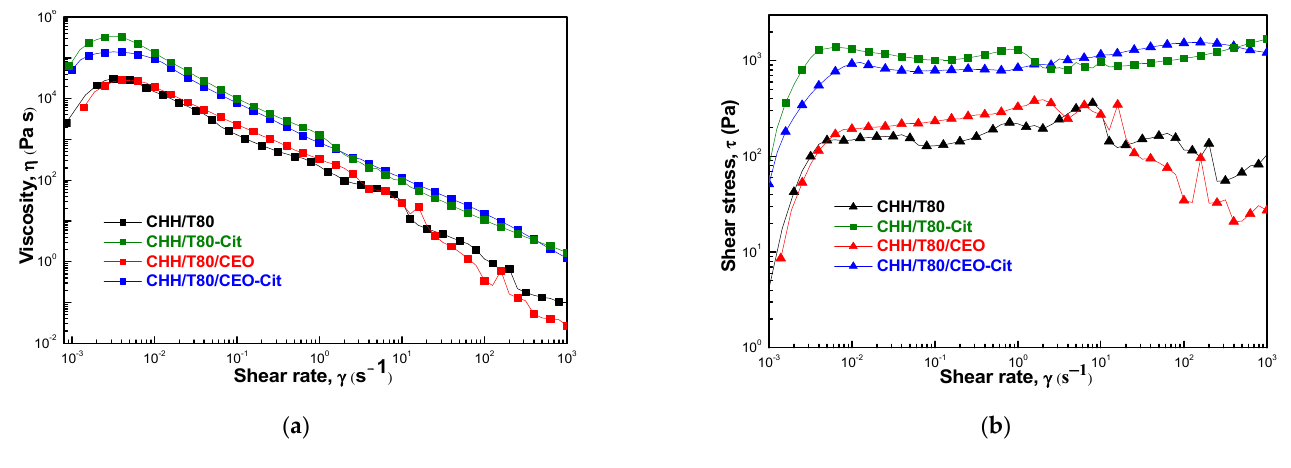
Figure 8. The variation of dynamic viscosity ( a ) and of shear stress ( b ) with shear rate for chitosan- based xerogels(CHH/T80), citrate cross-linked (CHH/T80-Cit) and loaded with clove essential oil (CHH/T80/CEO).